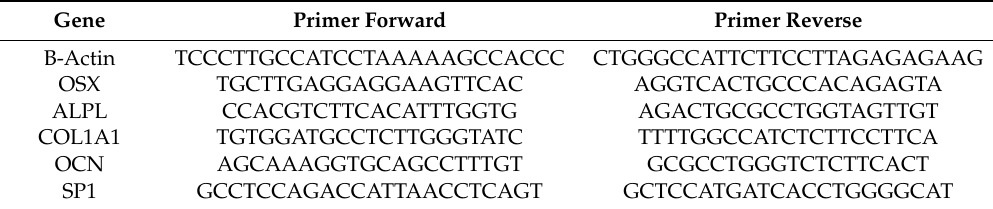
Table 1. Primer sequence used for gene expression